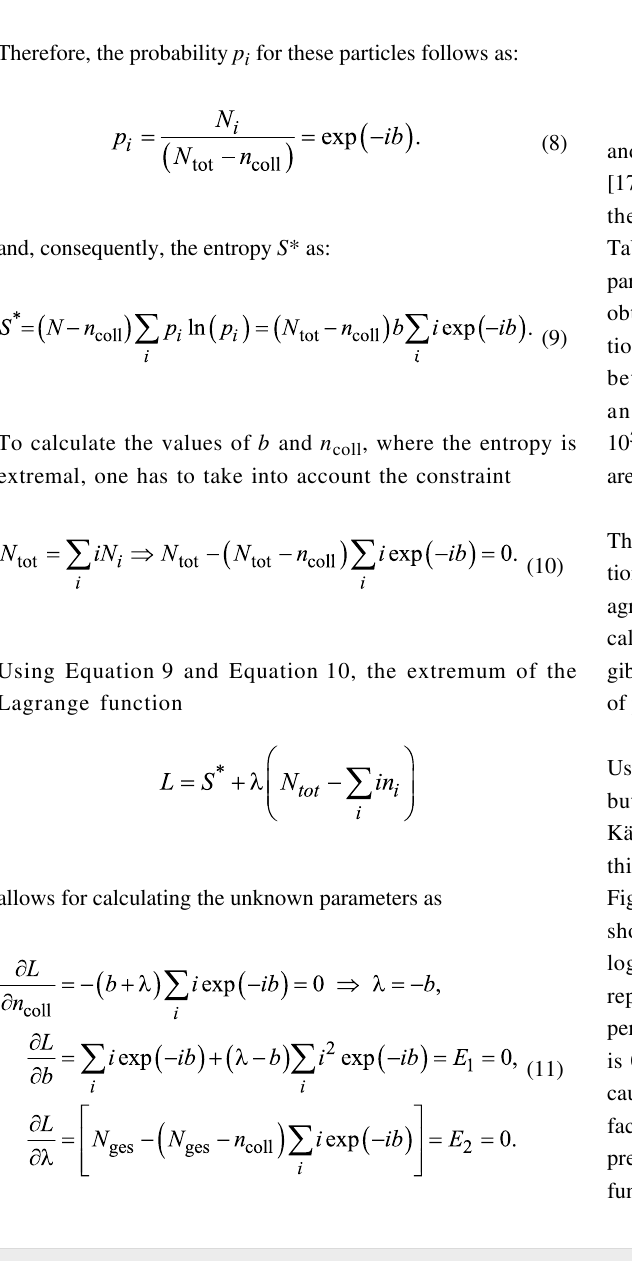
Table 1: Comparison of the parameters a and b